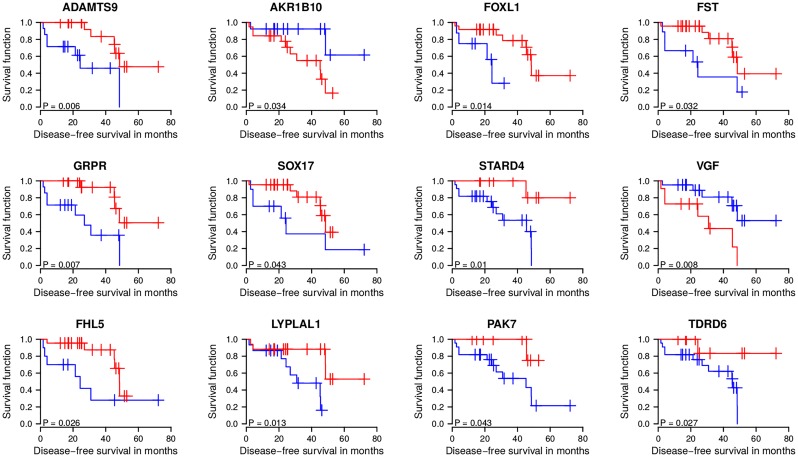
Marker gene-based separation of irradiated prostate cancer patients into early and late relapse groups.Potential radioresistance driver genes revealed from DU145 (top and middle row) and LNCaP (bottom row) were analyzed for their expression behavior in 32 irradiated prostate cancer patients from TCGA. Expression levels of each marker gene across the 32 patients were used to determine a marker gene-specific optimal cutoff for disease-free survival risk curves separating patients with low (blue curve) and high (red curve) marker gene expression with respect to the constraint that at least 8 patients must be assigned to each curve. Log-rank test p-values indicate that these selected marker genes enable a separation of irradiated prostate cancer patients into early and late relapse groups. Shown are standard approximate log-rank test p-values that only marginally deviated from exact log-rank p-values determined by exhaustive computations, except for FOXL1 that had a clearly less significant exact log-rank p-value of 0.076 (see Methods for details and S4 Fig). See S1 Text for a detailed discussion of the driver candidates in the context of the existing literature.